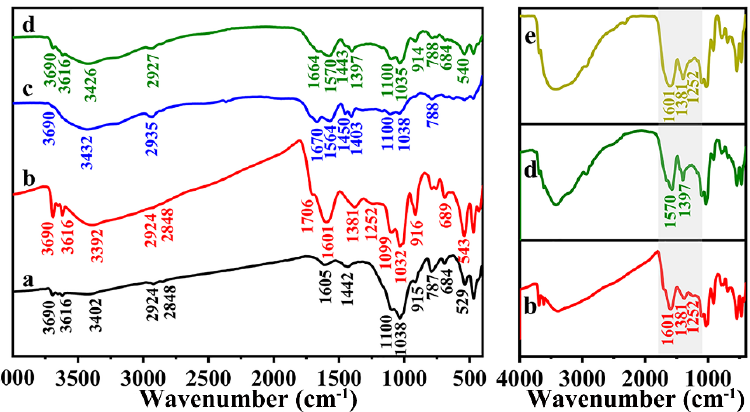
Figure 1. FTIR spectra of OSSC (a), FA (b), PAMS (c), PAMFS (d), and the physical mixture of PAMS with FA (m PAMS /m FA =10/1.5) (e).